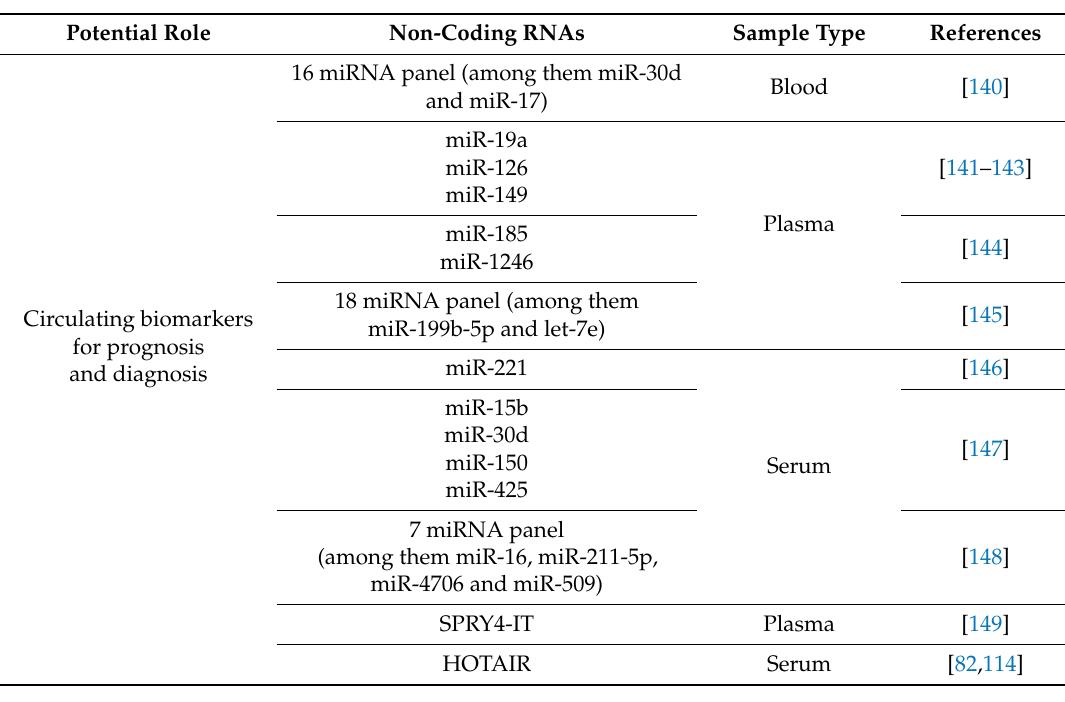
Table 3. Promising results that recommend non-coding RNAs as circulating biomarkers for potential clinical